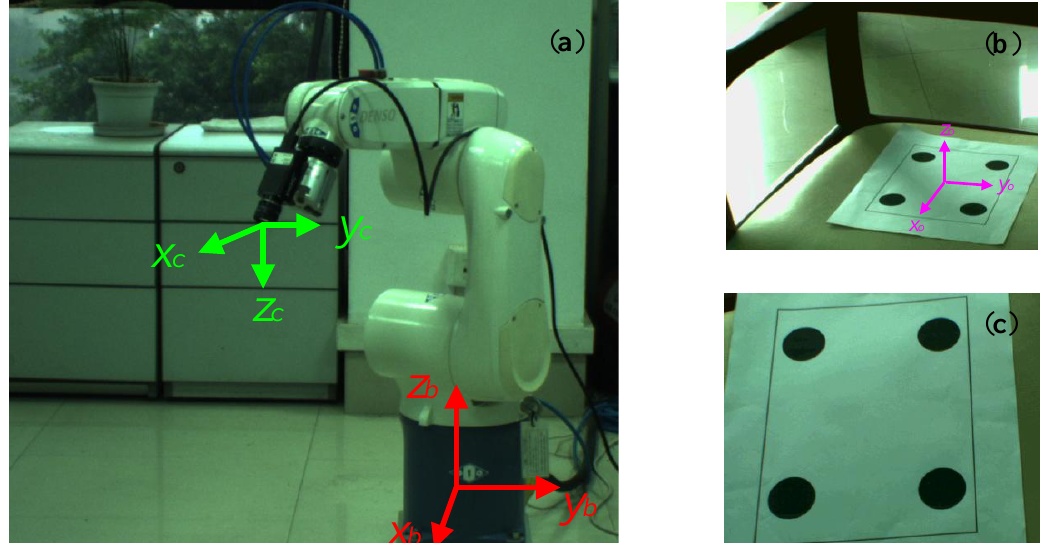
Figure 13. ( a ) Experimental environment with eye-in-hand configurations. ( b ) Initial features. ( c ) Desired features.